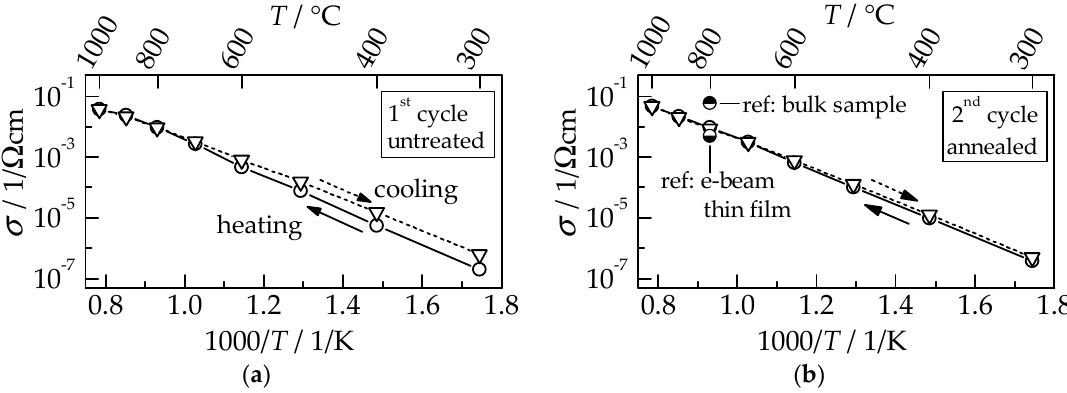
Figure 7. Electrical conductivity σ of the GDC10 film (with a thickness 1.2 µm) in an air atmosphere upon heating and subsequent cooling: ( a ) 1st cycle using the untreated, as-deposited film and ( b ) consecutive 2nd cycle of the identical film annealed at 1000 °C. Literature values at T = 800 °C are inserted in subfigure ( b ) for comparison (films by e-beam evaporation [3] and sintered bulk samples [5]).